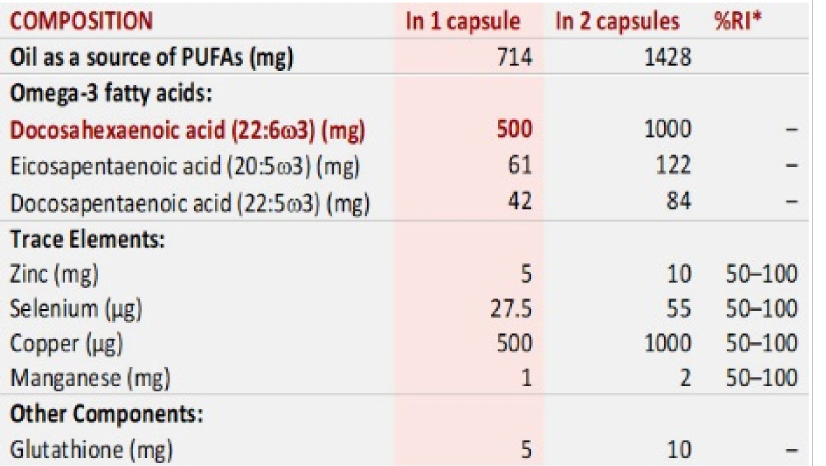
Figure 3. Composition of the nutritional supplement Brudyitis ®® . * RI: reference intake for 1–2 cap- sules. ω -3: omega 3; PUFAs: polyunsaturated fatty acids; TG: triglyceride; DHA-TG: enzymatically re-esterified